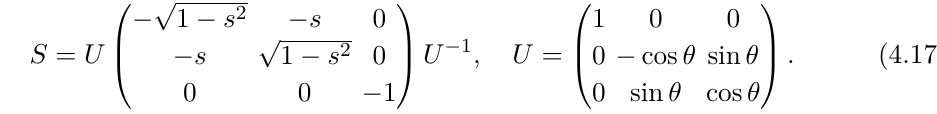
( s, θ ) log N + b + b − 1 where the n 0 1 N ( s, θ ) is given by eq. n